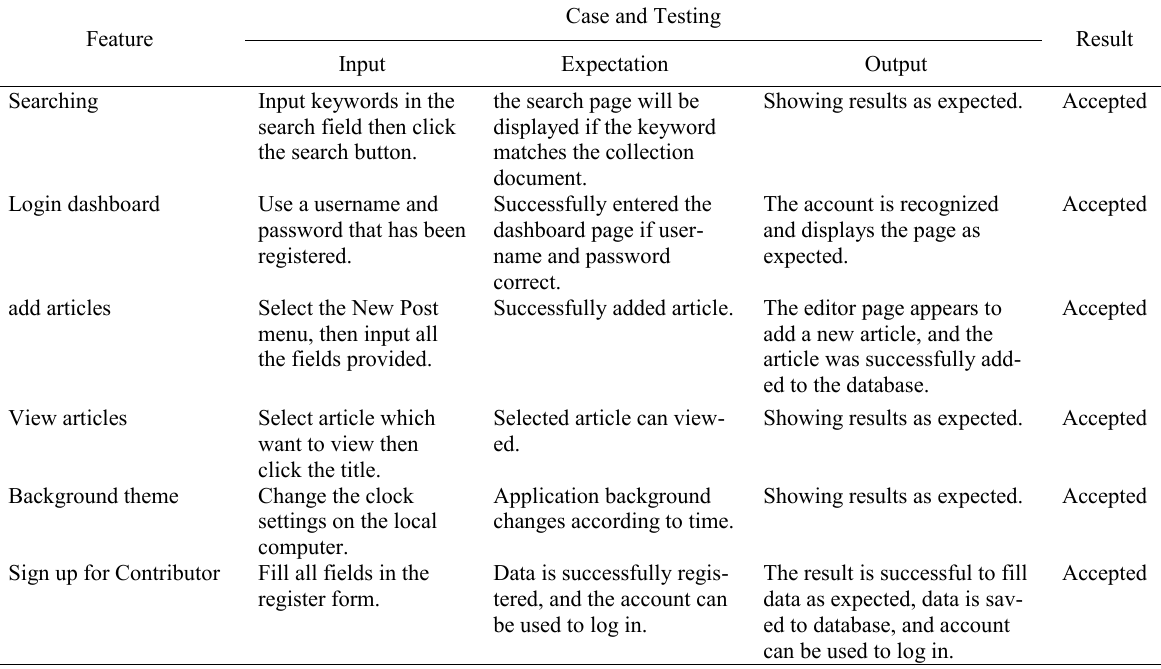
TABLE 3 B LACK BOX T ESTING R